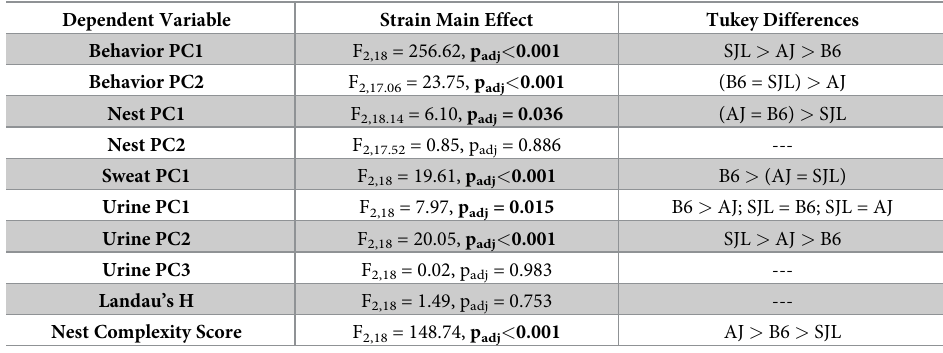
Table 3. Strain patterns on VOC profile and behavior based on mixed models.